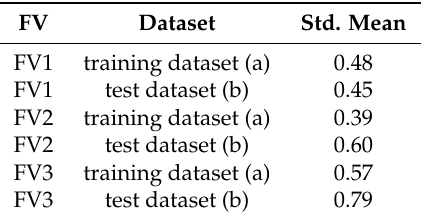
Table 4. Mean of the standard deviation of all the features of the training dataset (a) and the test dataset (b) with all the attacks for each feature vector